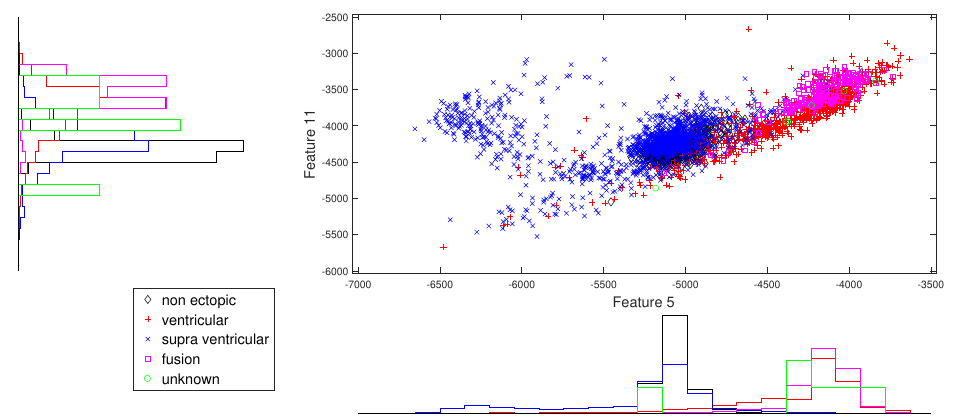
Figure 4. Scatter plot with marginal histogram for log entropy (IMF1) vs. log entropy (IMF2).